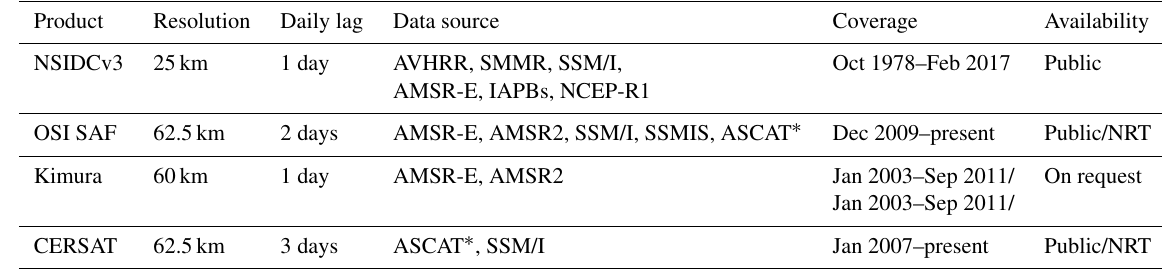
Table 3. Summary of the different ice motion datasets used in this study based on information obtained at the time of submission.